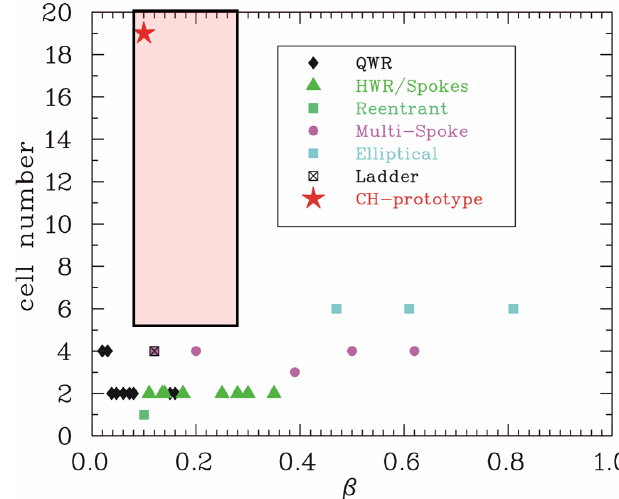
FIG. 43. (Color) Number of accelerating cells per cavity as a function of (cid:1) .